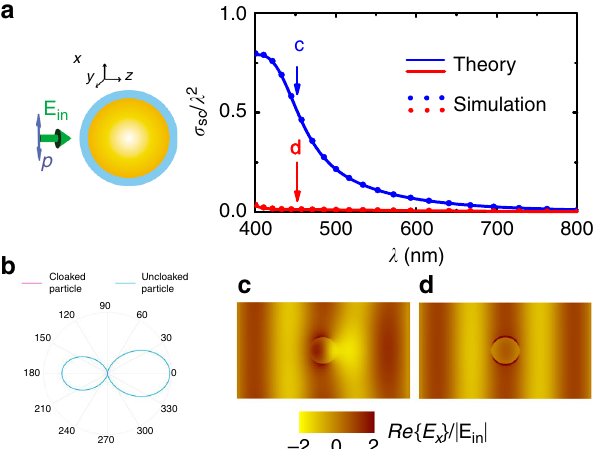
Fig. 2 Ultrabroadband tachyonic cloaking. a Normalized scattering cross section of the uncloaked (blue line) and cloaked (red line) spherical object shown in the left inset graphic. The object has relative permittivity ε r = 5 and magnetic permeability μ r = 1. The thickness of the cloak is only 10 nm, and inside it the average (dispersive) group velocity is ten times larger than the speed of light in vacuum ( 〈 v g 〉 ~10 c ). Solid lines correspond to analytical calculations (see Supplementary Notes 3, 4), while the symbols correspond to fi nite-element (Comsol) and integral-equation (CST) simulations that precisely coincide. b Polar plot of the scattering from the uncloaked (blue line) and cloaked (red dot, at the center) spherical object at an incident wavelength λ = 450 nm. c , d Electric- fi eld pro fi le ( E x component) in the xz plane, including the center of the spherical object, for the uncloaked ( c ) and for the cloaked ( d ) particle, respectively, at an incident wavelength λ = 450 nm. Note in ( c ) the perturbed fi eld exiting the